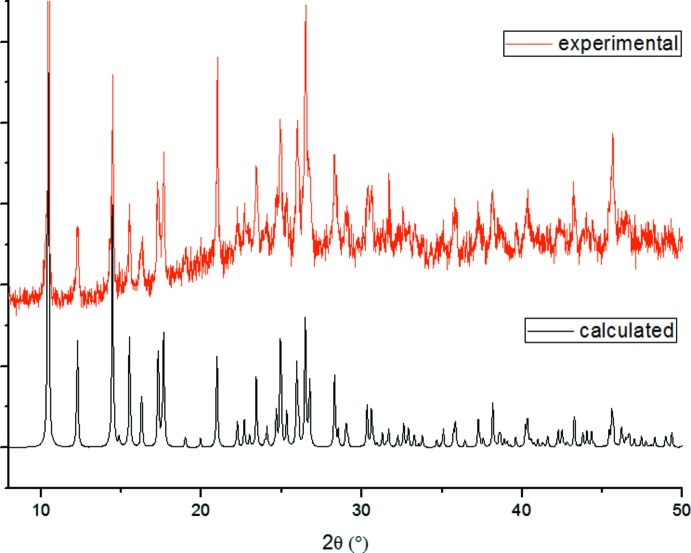
Comparison between the experimental and theoretical powder diffractogram for the title complex. The calculated diffractogram was simulated using Mercury software (Macrae et al., 2020 ▸) from the CIF file.